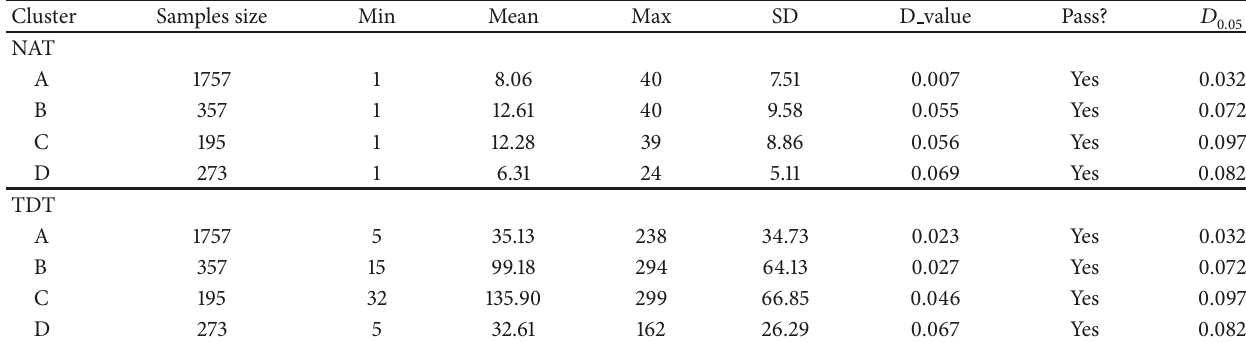
Table 7: Statistics and the testing result of NAT and TDT using K-S